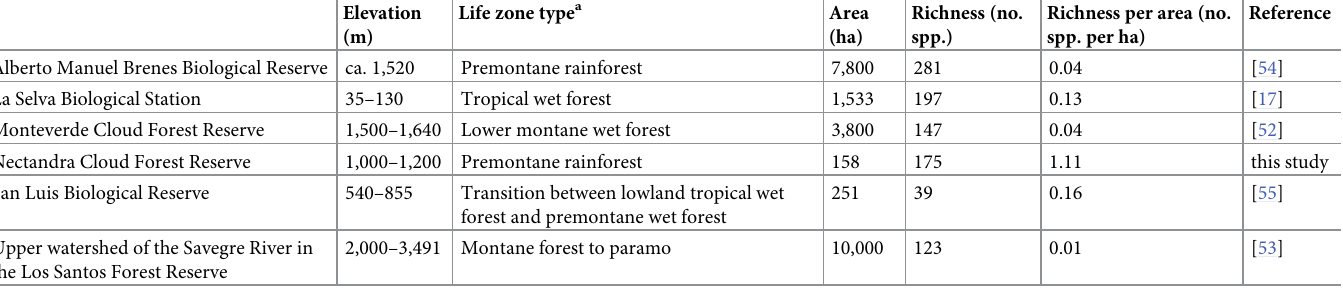
Table 2. Species richness of pteridophytes at protected areas in Costa Rica. A single non-native species, Macrothelypteris torresiana , was excluded from calculations for Nectandra.